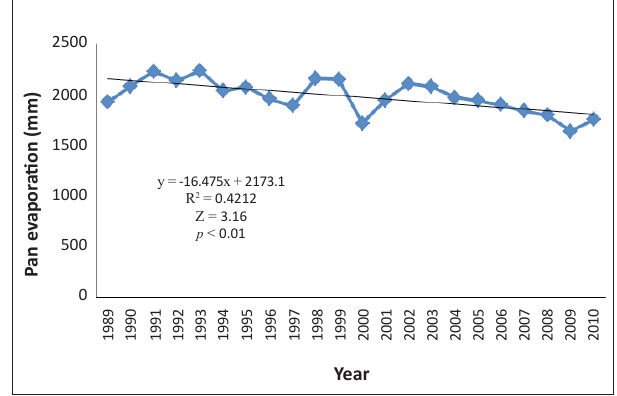
FIGURE 3: Changes in annual S-pan evaporation (mm) values for Nqweba Dam over the period 1989–2010.